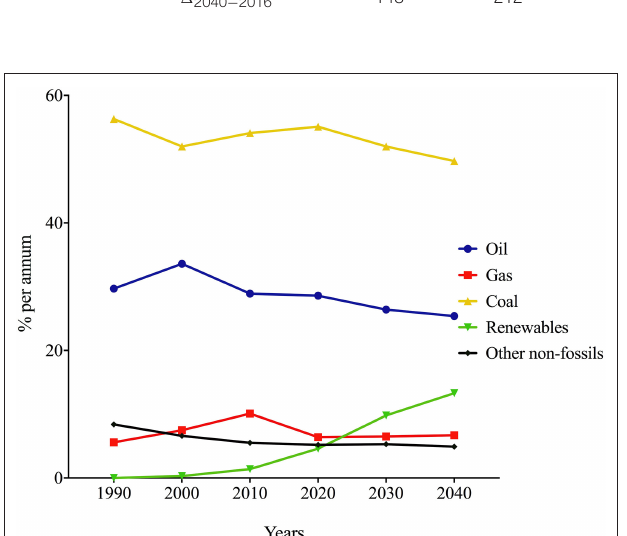
FIGURE 4 | Share of primary energy mix. Data Source: BP Energy Outlook 2018 (BP, 2018).